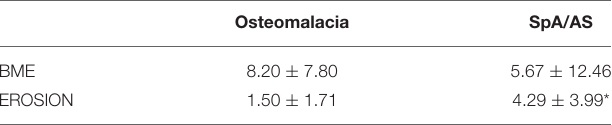
TABLE 4 | SIJ–MRI scores of patients in both groups.